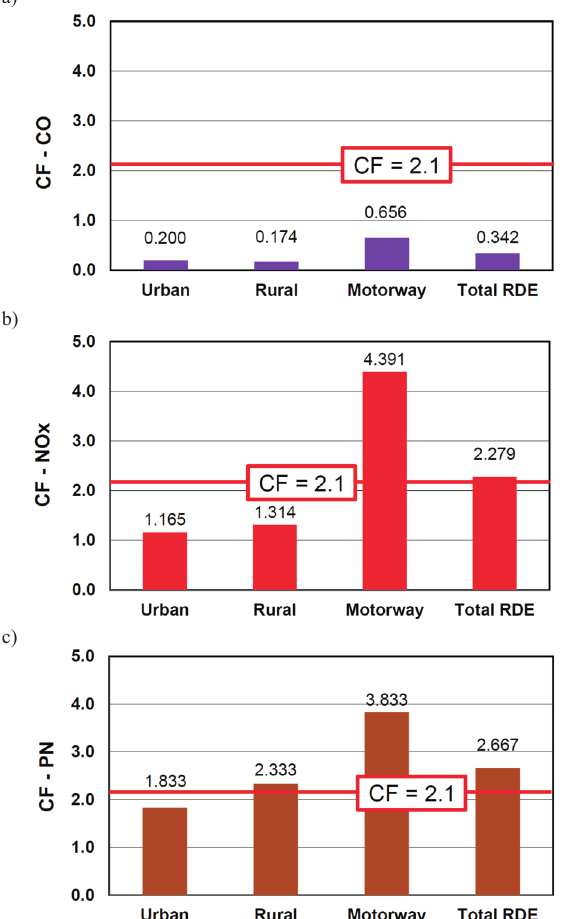
Fig. 11. Conformity factors of carbon monoxide (a) nitrogen oxides (b) and particle number (c) obtained in each test section for vehicle with